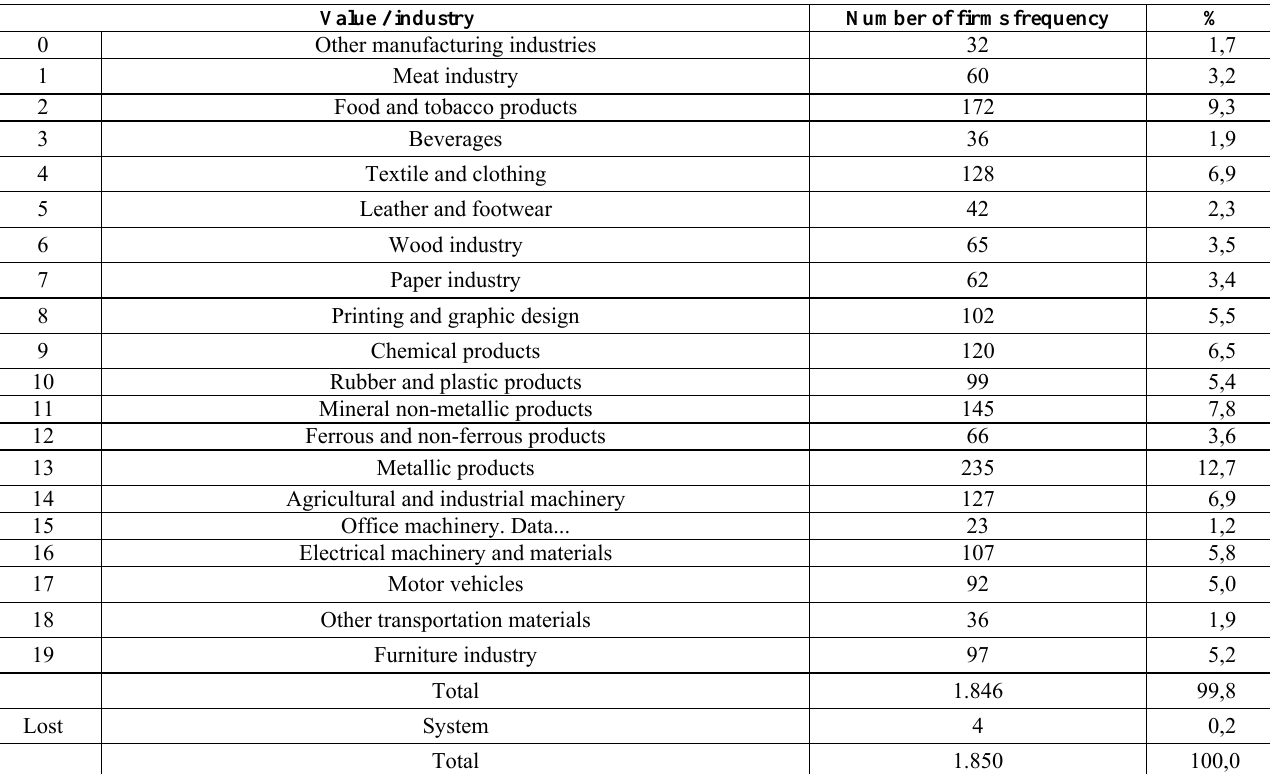
Table 3: Values and distribution of the sample within the sectors of